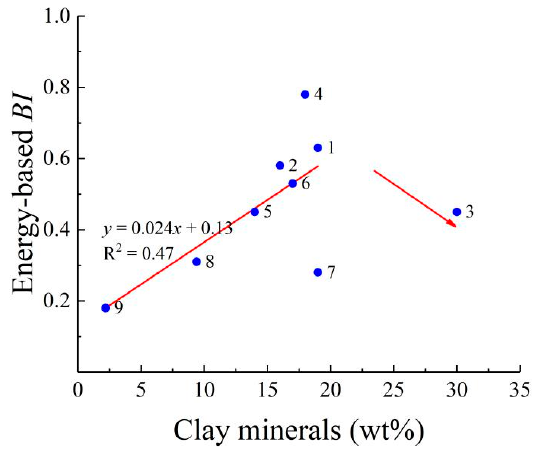
Figure 16. The relationship between energy-based BI and the content of clay minerals.